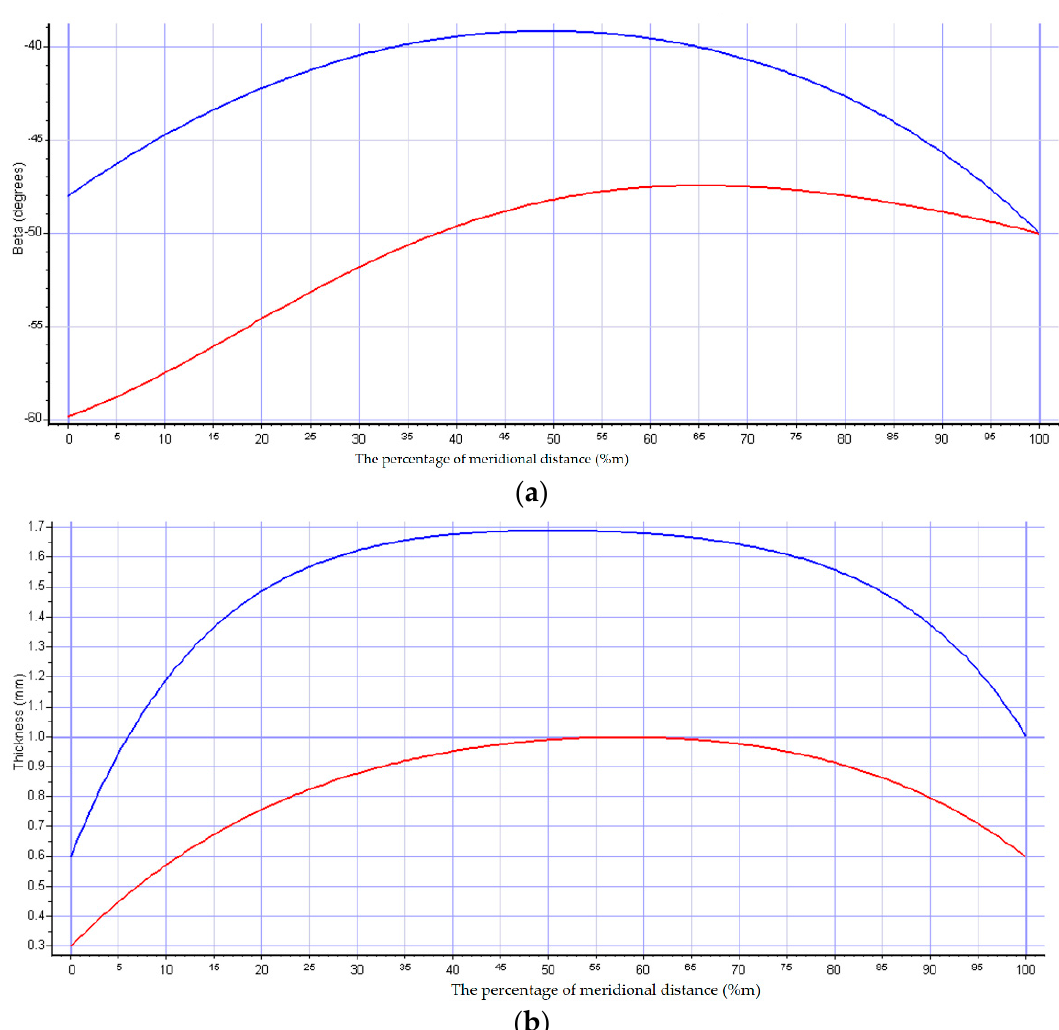
Figure 2. Distribution of the semi-open impeller. ( a ) Beta distribution, ( b ) Thickness distribu- tion.